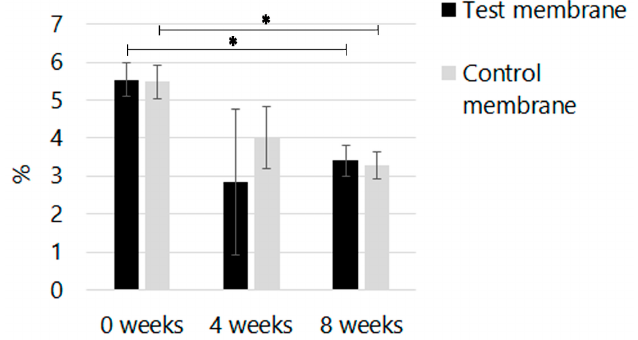
Figure 5. In vivo height changes of the alveolar ridge. Bone defects height changes at different time points, where 0 indicates surgery day. * P < 0.001